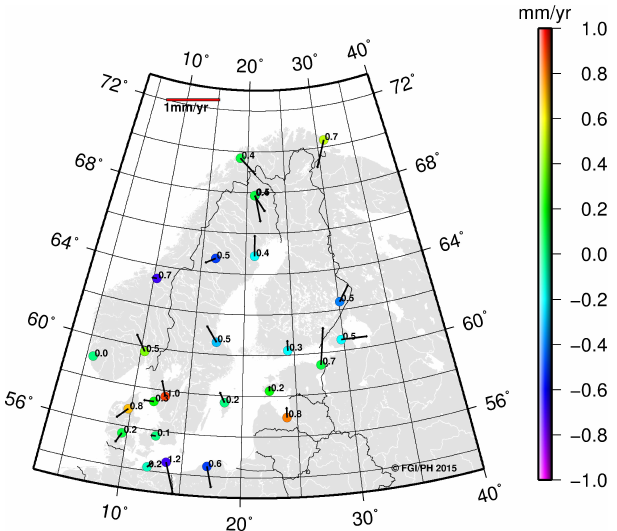
Figure 4: Observed ETRF2000 station velocities of the EPNC1785 minus re-aligned NKG RF 03 vel intraplate velocities ( NKG RF 03 vel ETRF 2000 ), i.e. residuals of the re-alignment. Vec- tors show horizontal, coloured circles vertical and values next to the station 3D differences in